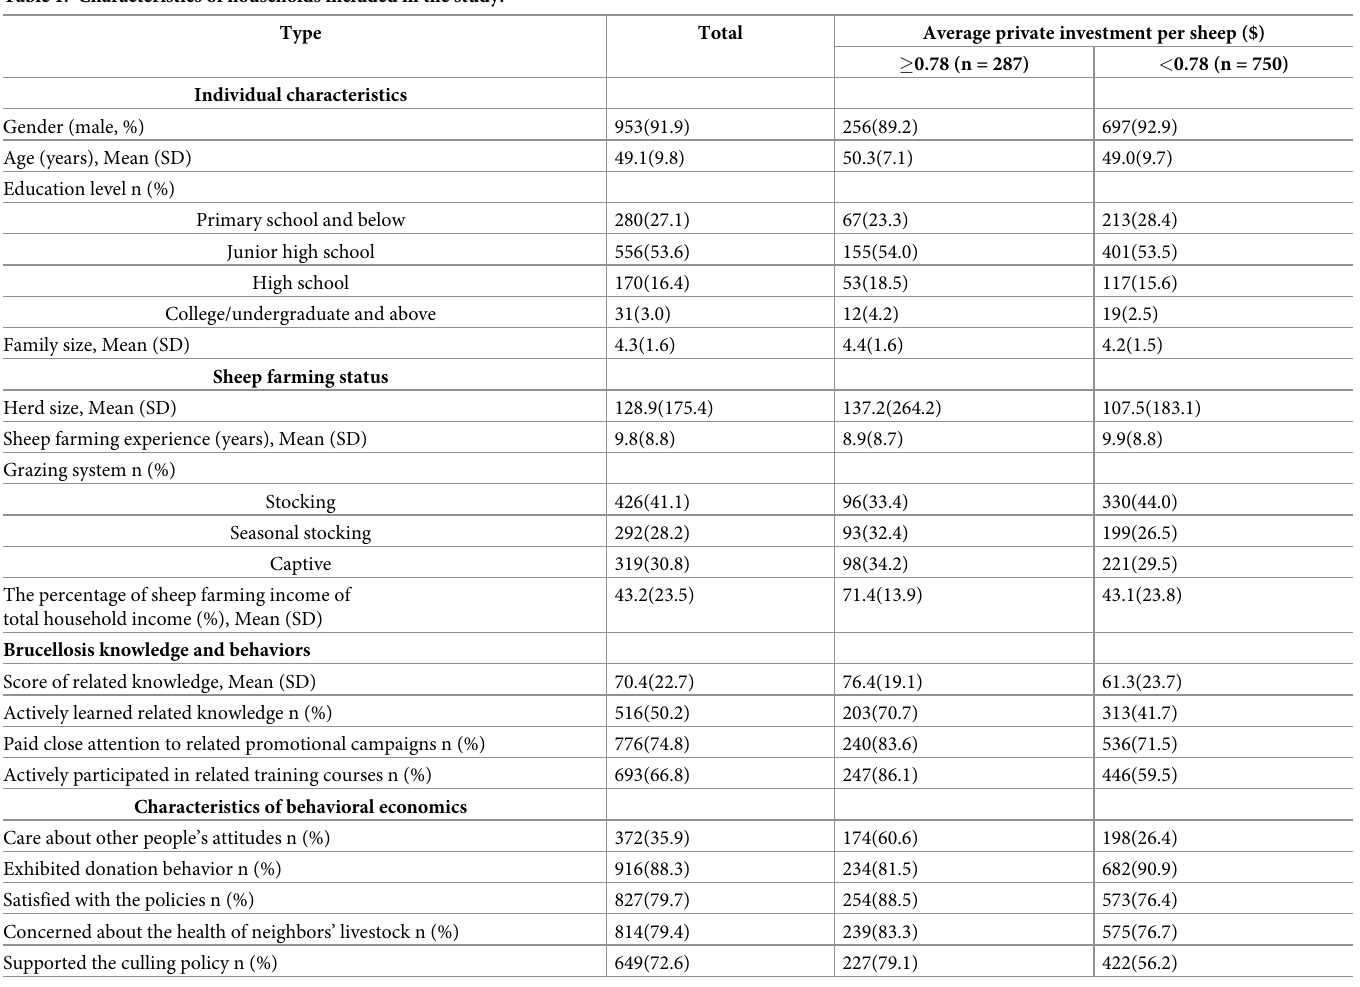
Table 1. Characteristics of households included in the